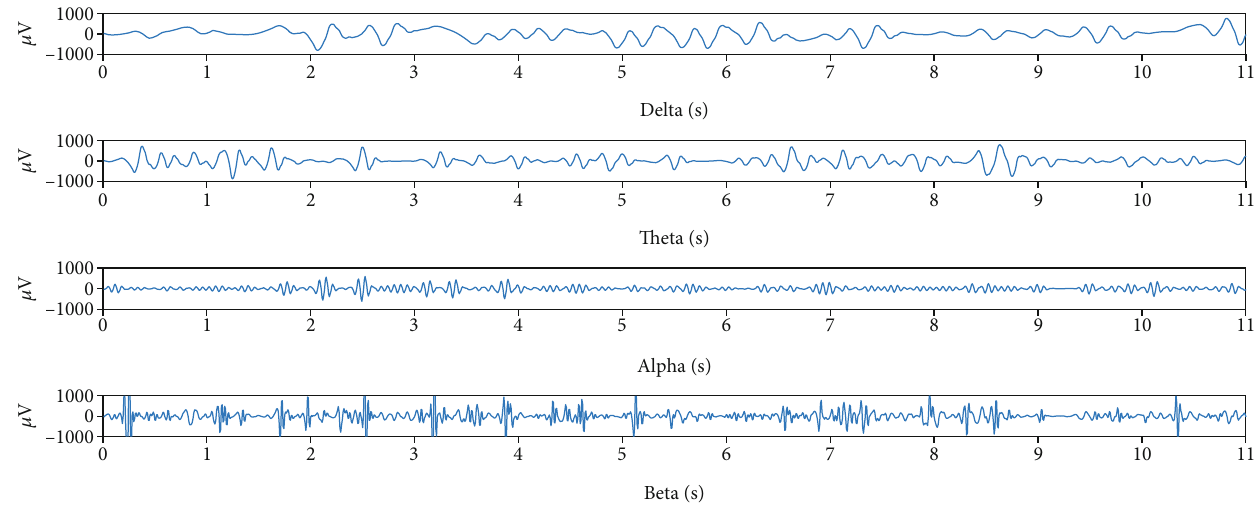
Figure 4: After removing the artifacts such as EMG and EOG, the useful signals were obtained. After wavelet packet function decomposition and reconstruction, the LFP signals of four bands ( δ , θ , α , and β ) were obtained for the next step of feature calculation.